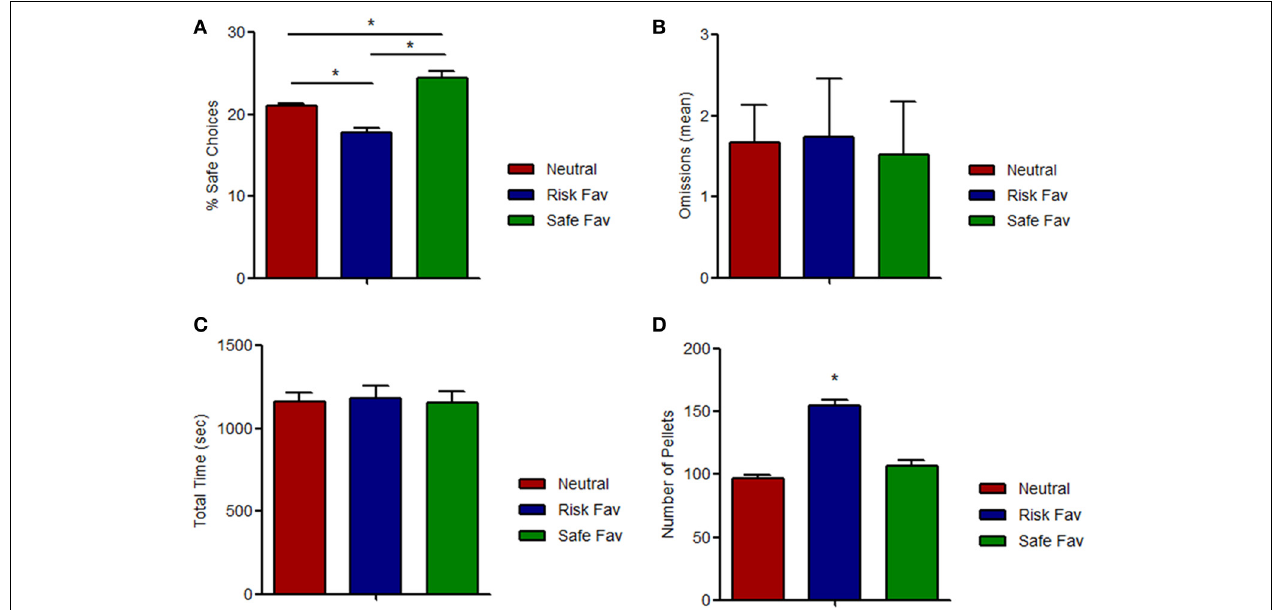
FIGURE 3 | Effects of outcome value manipulation on risk-based decision. (A) Behavioral responses to outcome value manipulations. Increases (doubling) in the amount of reward of the risky choices (risk favorable condition) or the safe choices (safe favorable condition) lead to a reduction (risk favorable) or increase (safe favorable) in the % of safe choices,